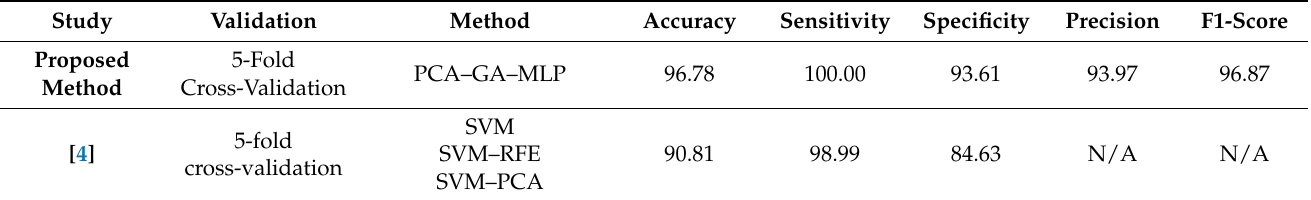
Table 8. Comparison of the proposed method with the best results in the literature in diagnosing